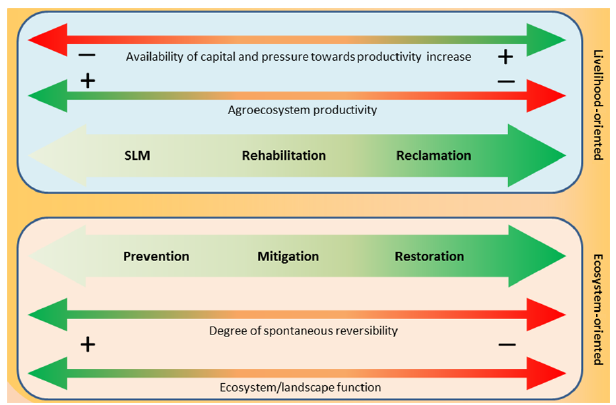
Figure 1. Soil restoration strategies, either livelihood- or